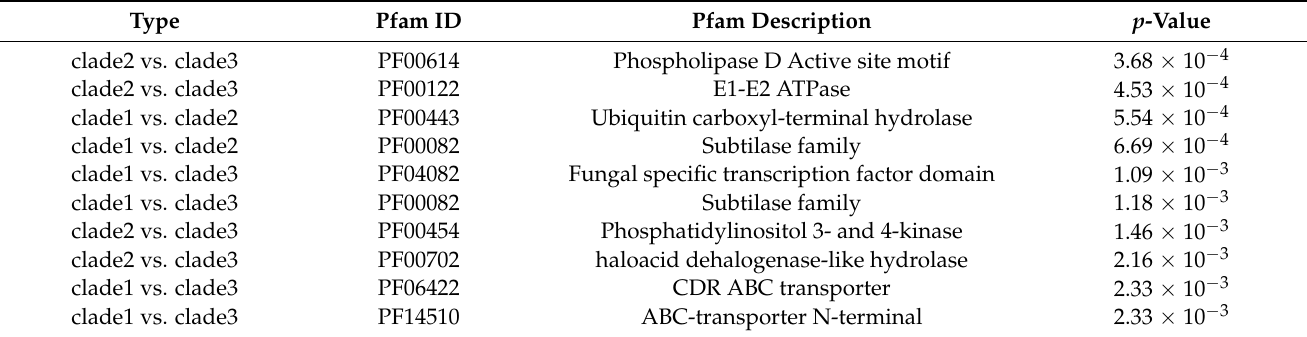
Table 2. The Pfam enrichment analysis of the core genes in rice-infecting